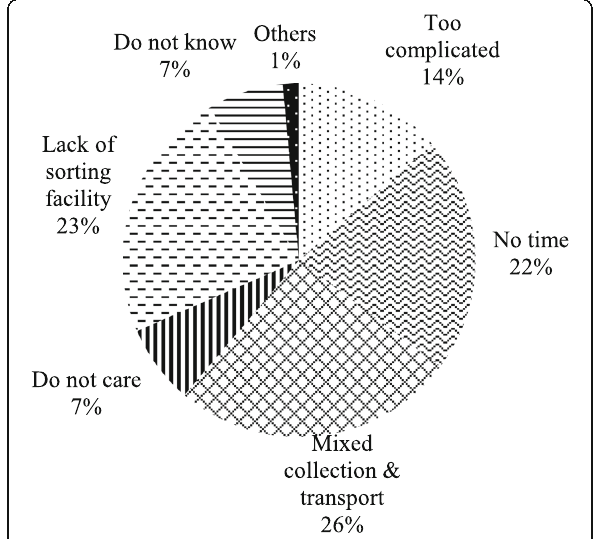
Fig. 2 Respondents ’ main reasons for not participating in waste sorting